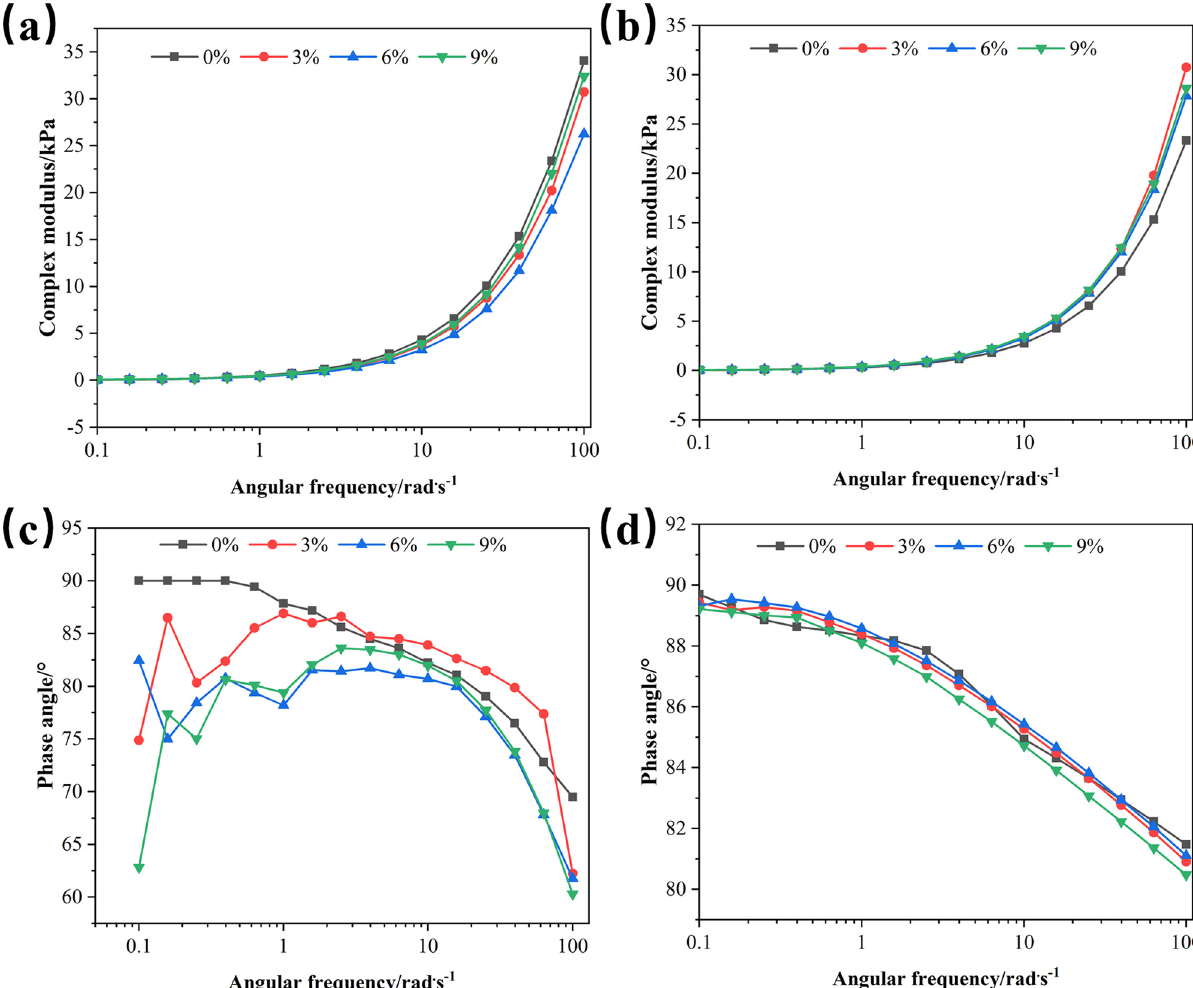
Figure 3: Frequency scanning results under di ff erent parallel plates: ( a ) 8 mm G *, ( b ) 25 mm G *, ( c ) 8 mm δ , and ( d ) 25 mm δ